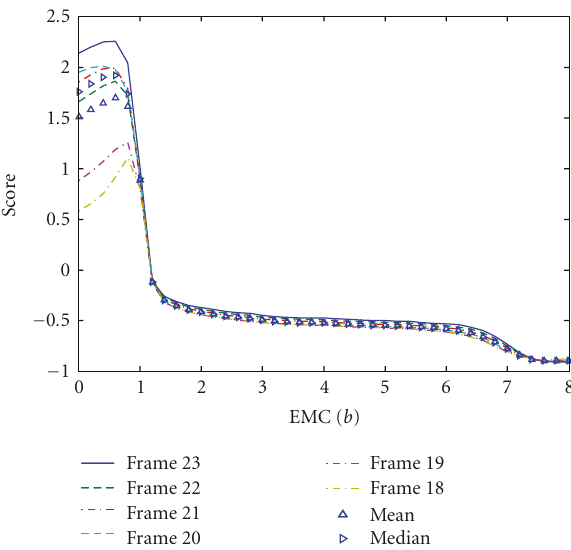
Figure 20: NA23A sequence, s n = 4 A S versus b , g = 1 case and Max Numbers = 1.